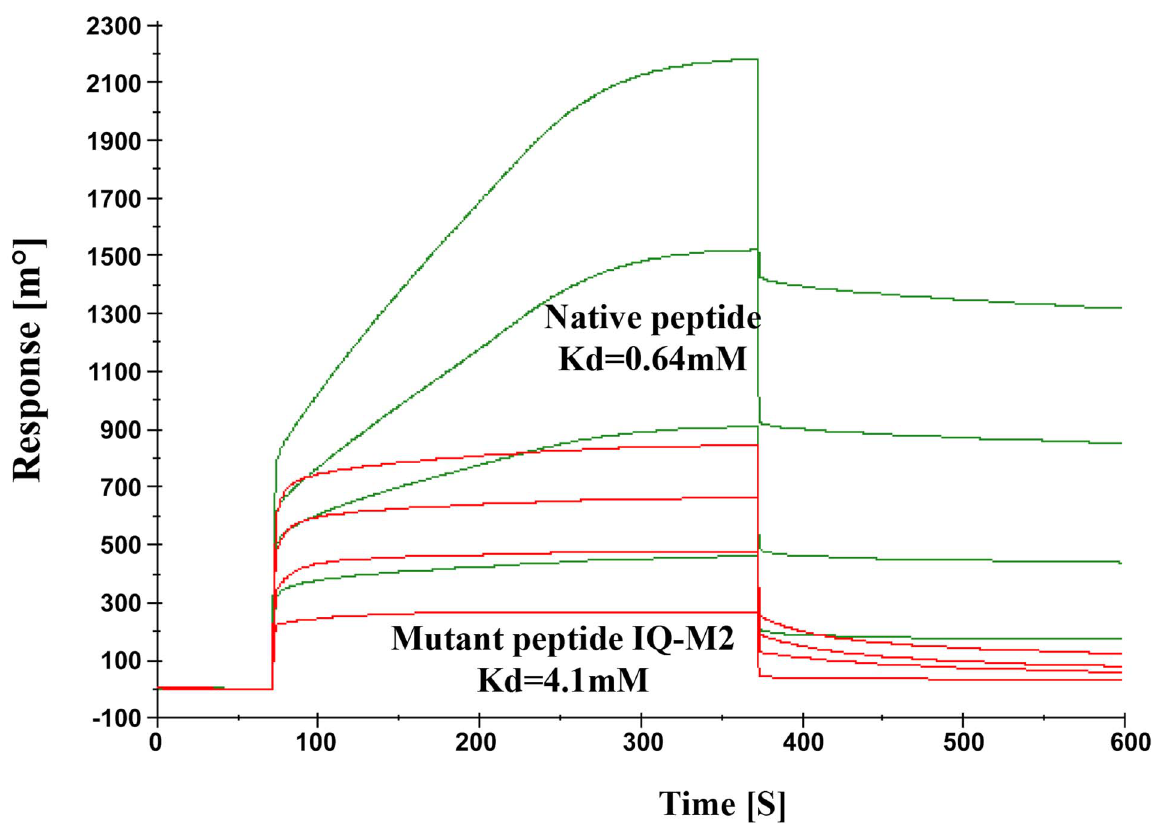
Fig 11. Model Validation. SPR Sensogram represents the binding of Native IQ motif peptide (green) and Mutant IQ-M2 peptide (red) to EhCaBP5 immobilized surface.